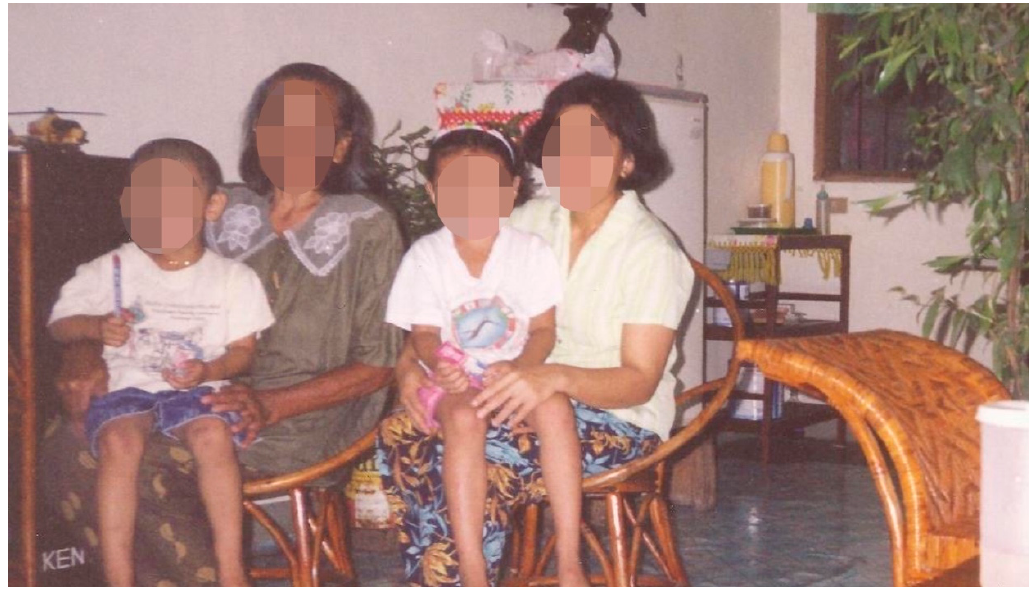
Figure 1. Lance’s Figure 1. Lance’s photo.